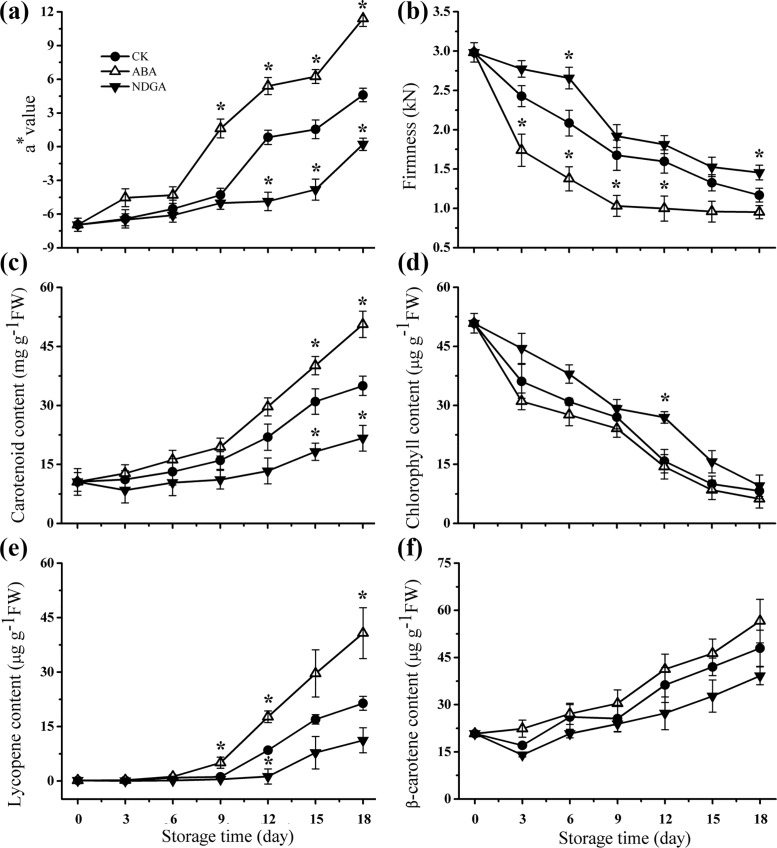
Effects of ABA and NDGA applications on tomato ripening-related physiological indexes during storage at 20°C.(a) The changes of a* value. (b) The changes of fruit firmness (kN). (c) The changes of total carotenoid content during tomato ripening. (d) The changes of chlorophyll content. (e) The changes of lycopene content. (f) The changes of β-carotenoid content. Error bars represented SE of three biological replicates, and asterisks (*) indicates significant difference (P<0.05) between the value in ABA treatment group or NDGA treatment group and that in CK (control).